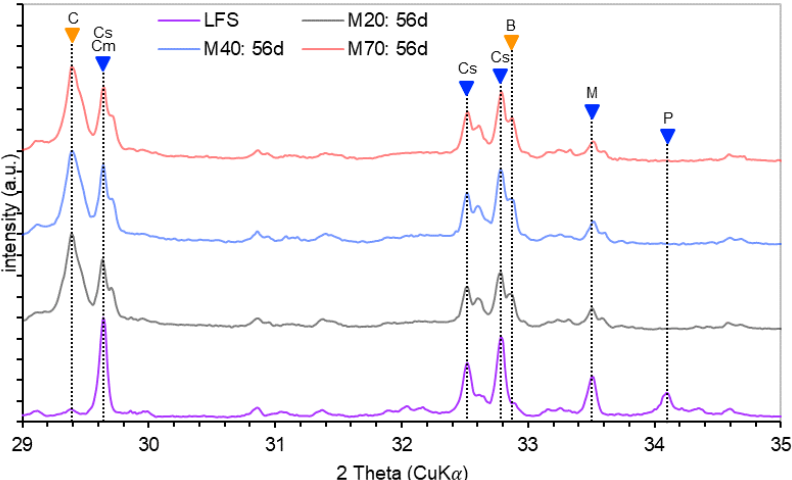
Figure 7. Detail of the changes between 29° and 34° 2 θ between the raw slag and the activated slag at different temperatures and 56 days of curing C: calcite, Cs: calcium silicate, Cm: magnesian calcite, B: brucite, M: mayenite, P: portlandite.